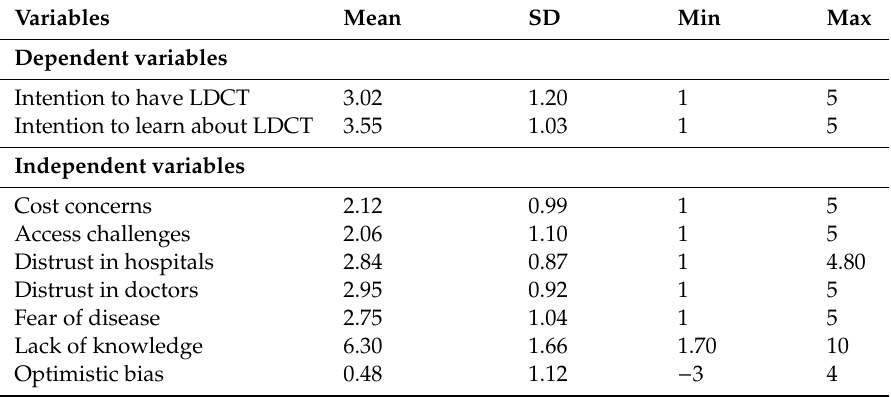
Table 2. Descriptive Statistics of Independent and Dependent Variables ( N =